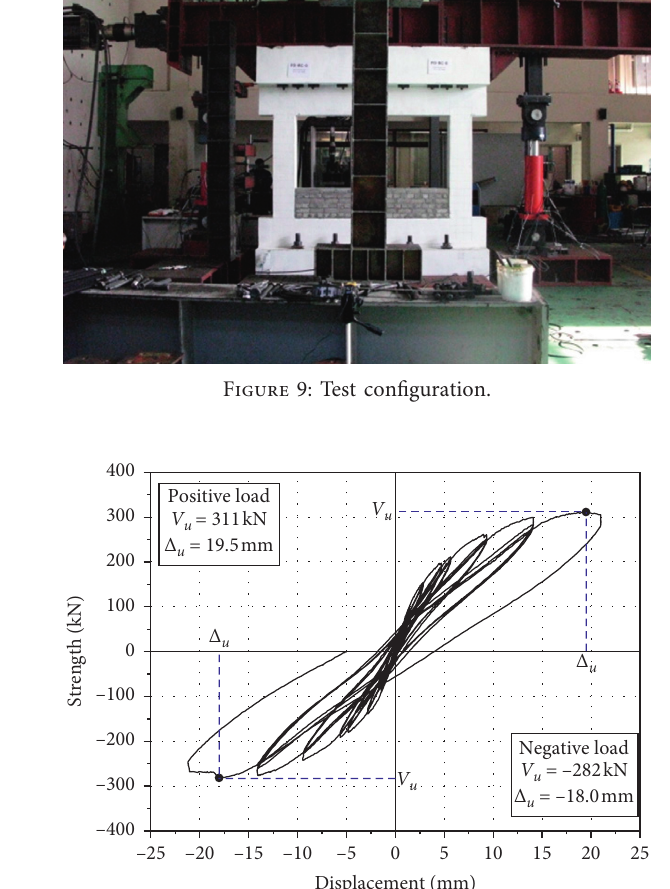
u : ultimate shear strength Δ u : dis-